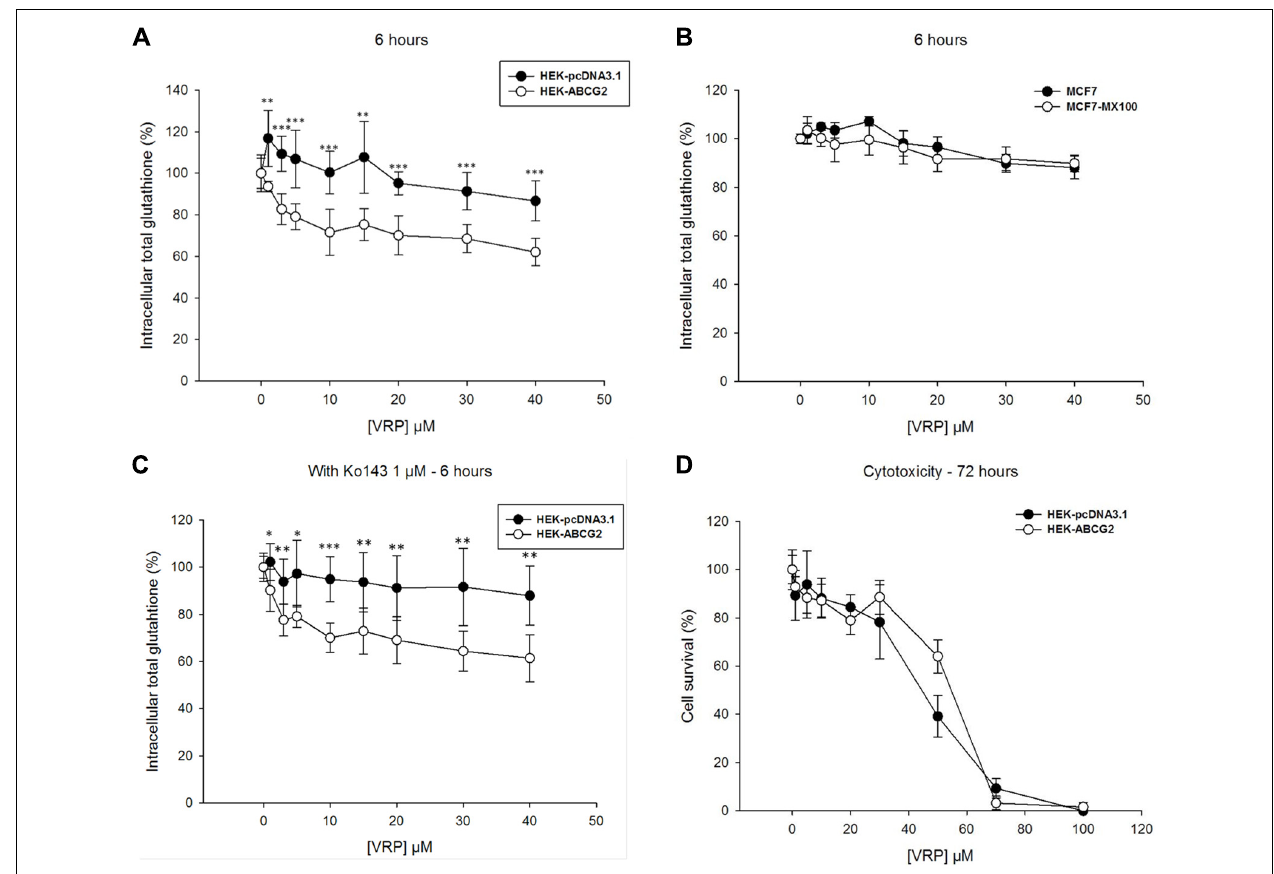
FIGURE 3 | Effects of verapamil on intracellular glutathione depletion and cells survival. Verapamil induced a significant intracellular GSH depletion in HEK293 transfected cells during 6-h incubation (A) , but not in the MCF7 selected cells (B) when comparing ABCG2-overexpressing cells (white circles) to control cells (black circles). This weak effect was not inhibited by Ko143 (C) , the difference in intracellular glutathione remaining